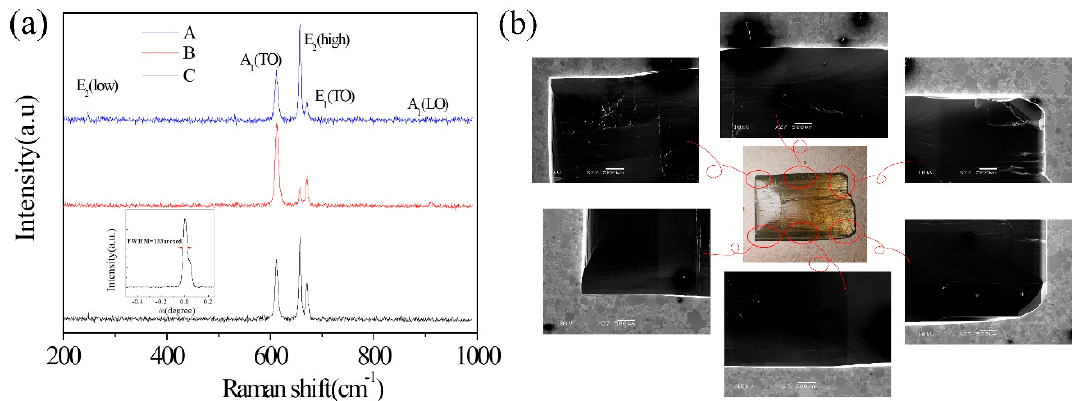
Figure 8. ( a ) Raman spectra of AlN crystals grown with di ff erent temperature field. The inset is X-ray rocking curve of sample C; ( b ) Low-magnification SEM image of seed crystal.